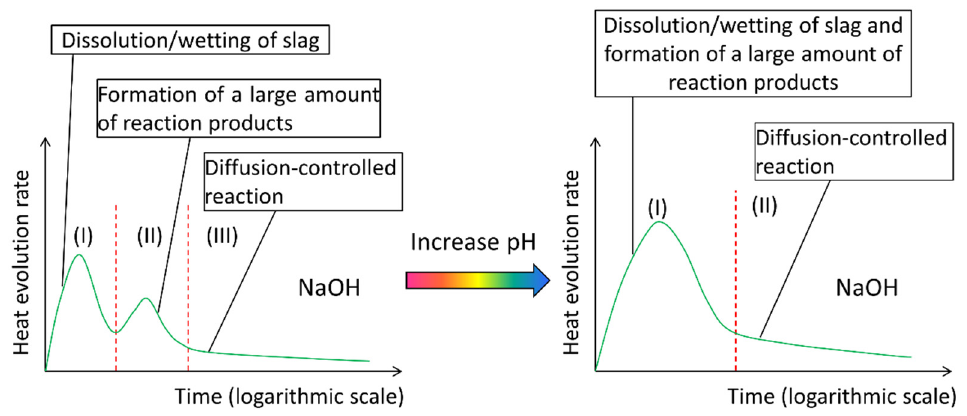
Figure 14. Schematic illustration of the e ff ect of increasing the pH of NaOH activator on the reaction kinetics of NaOH activated slag paste.